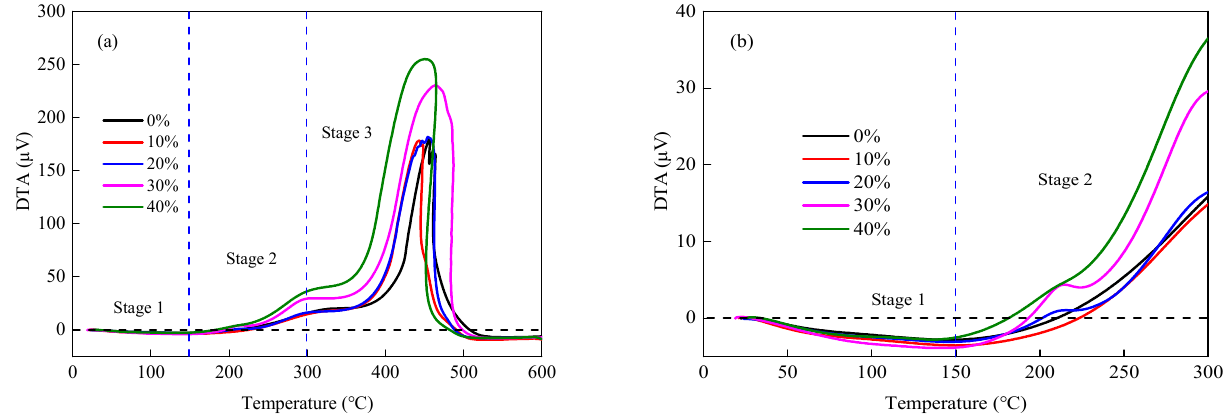
Figure 11. The DTA of the coal dust at 0–600 °C ( a ) and 0–350 °C ( b ).